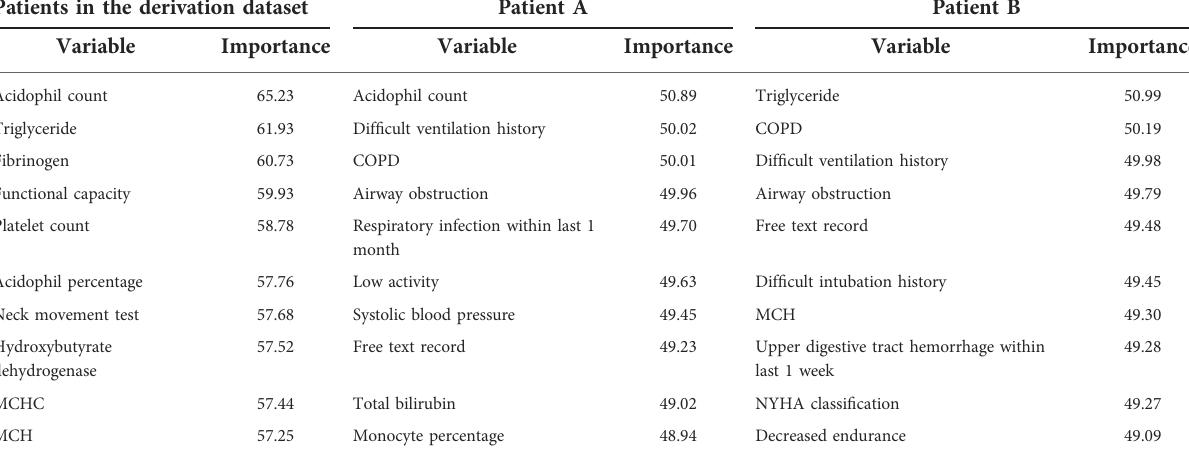
TABLE 2 Top ten most important variables in the deep neural network model for patients in the derivation dataset and the two case examples. Patients in the derivation